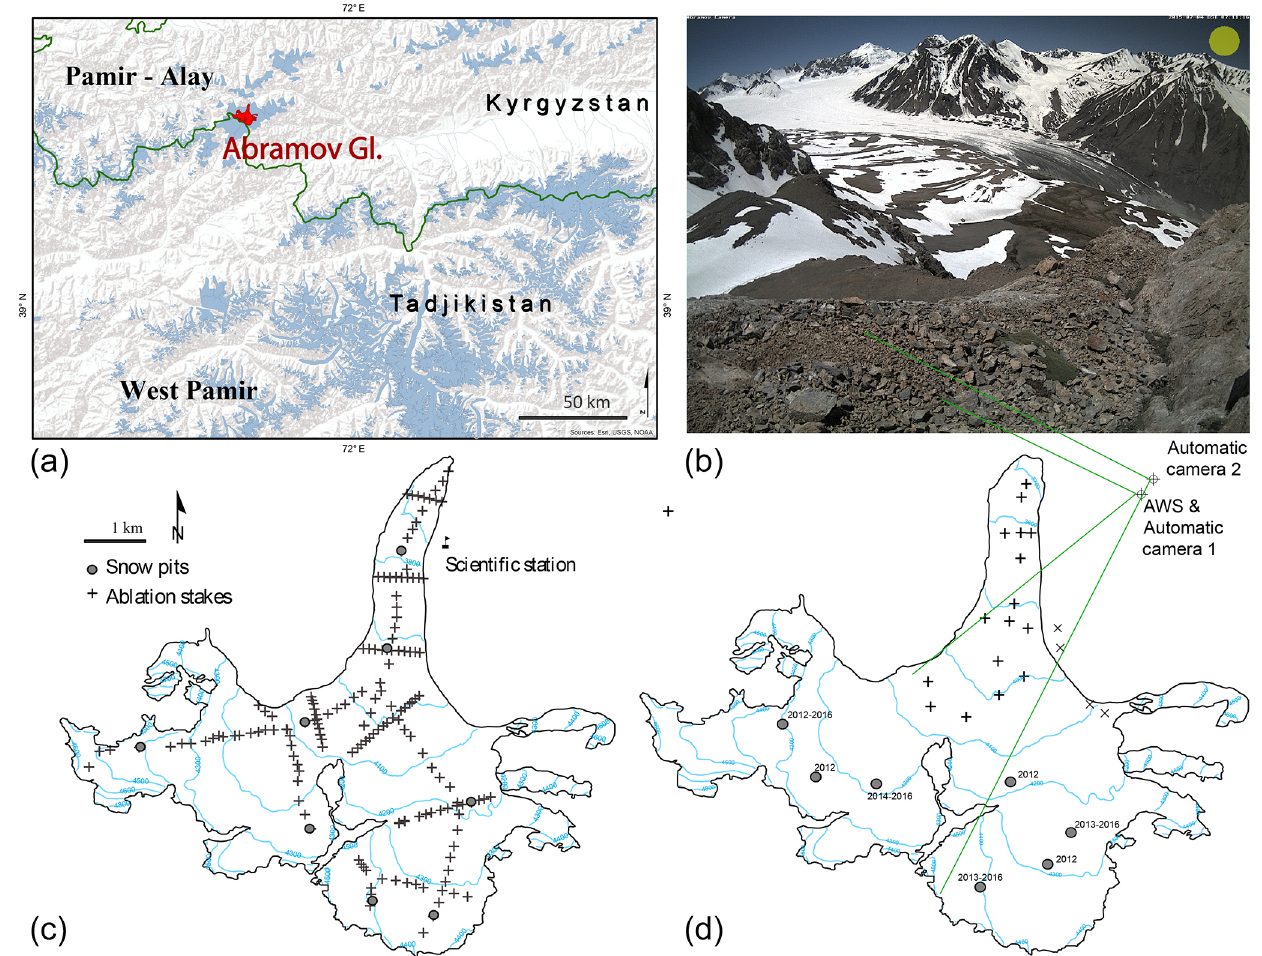
Figure 5. Historical (c) and new (d) mass balance network on the Abramov glacier (Kyrgyzstan) with corresponding (overview) map (a) and snow line camera picture (b)